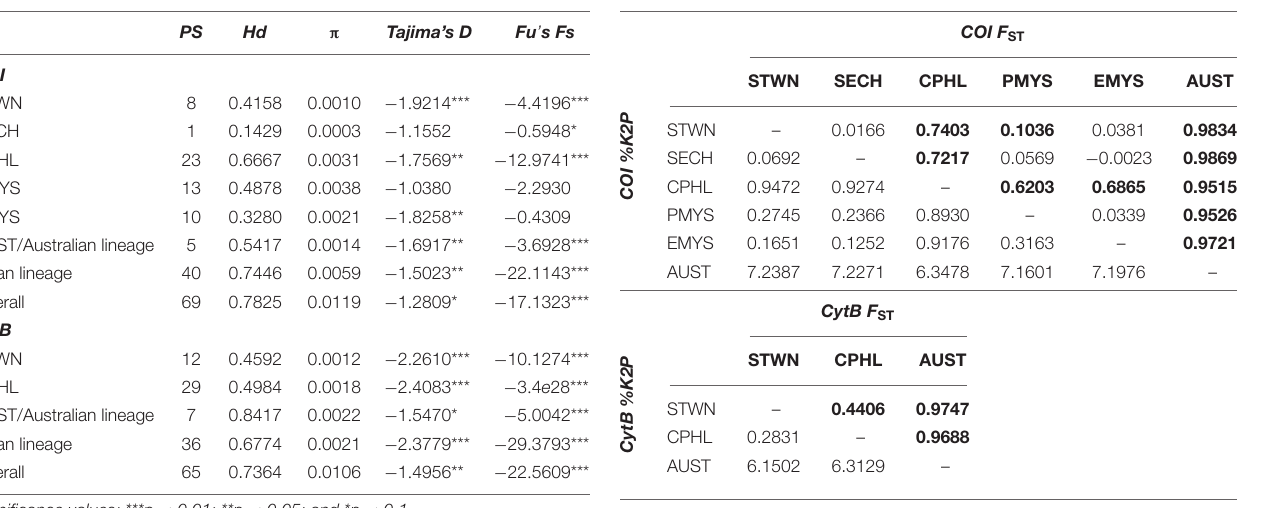
TABLE 3 | Population pairwise distances using F ST s (upper diagonals) and Kimura two-parameter (%K2P) (lower diagonals) for cytochrome oxidase I (COI) (upper table) and cytochrome B (CytB) (lower table).